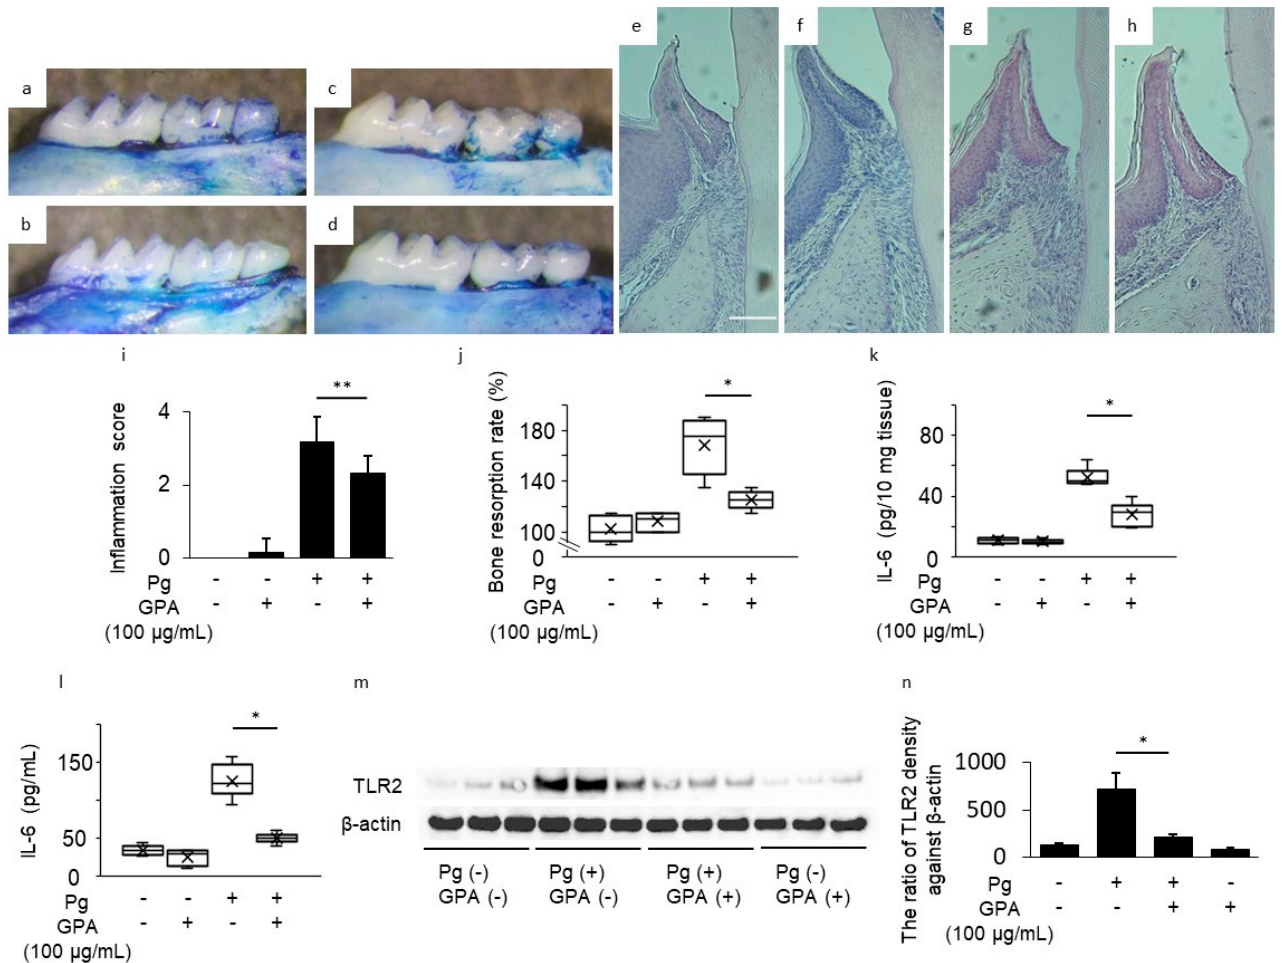
Figure 2. Inhibitory effects of geniposidic acid (GPA) on a Porphyromonas gingivalis -induced mouse periodontitis model. The mice were treated with P. gingivalis in the presence or absence of GPA and sacrificed, and the serum, gingival tissue, and upper molar bone were collected (( a ) PBS inoculation; ( b ): GPA inoculation; ( c ): P. gingivalis inoculation; ( d ): GPA + P. gingivalis inoculation, n = 6 /group). Destruction of the mouse periodontal tissue was visualized in hematoxylin and eosin-stained sections ( e ): PBS inoculation, ( f ): GPA inoculation, ( g ): P. gingivalis inoculation, h: GPA + P. gingivalis inoculation). Original magnification ×100; Scale bar = 100 µm. The inflammation score in sections from each group was evaluated ( i ). Data represents the mean ± SD of six mice per group. ( i ). Alveolar bone level of the upper jaw in each group ( j ). The amount of IL-6 in each group was determined using ELISA ( k : gingival tissue, l: serum). In the boxplot, the horizontal black lines within each box denote the median values, and boxes are extended from the 25th and 75th percentile. Whiskers above and below the boxes indicate the 10th and 90th percentiles, respectively, and cross marks